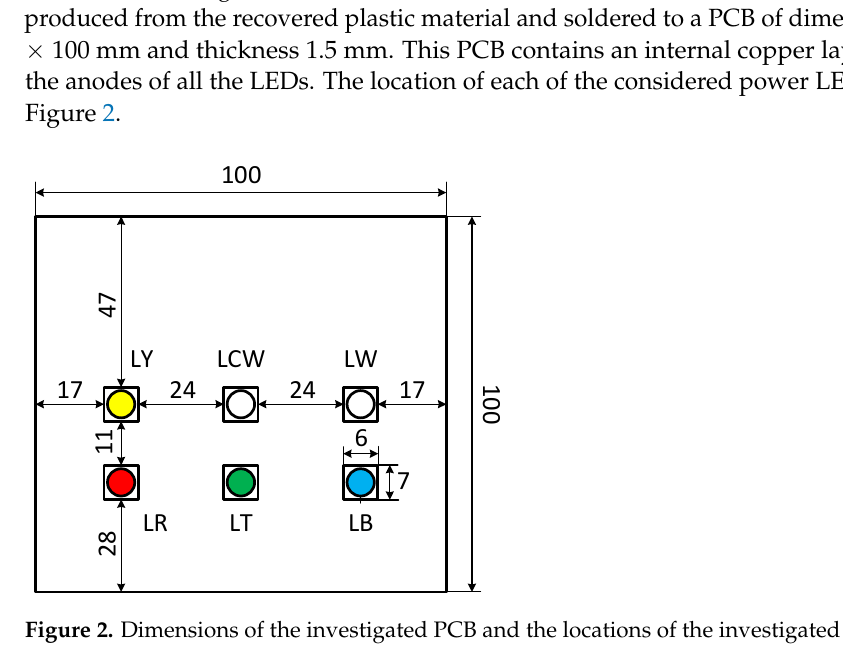
Figure 2. Dimensions of the investigated PCB and the locations of the investigated power LEDs. As is visible, the investigated devices are mounted in two rows, including three LEDs situated 24 mm apart from each other. The distance between these rows is equal to 11